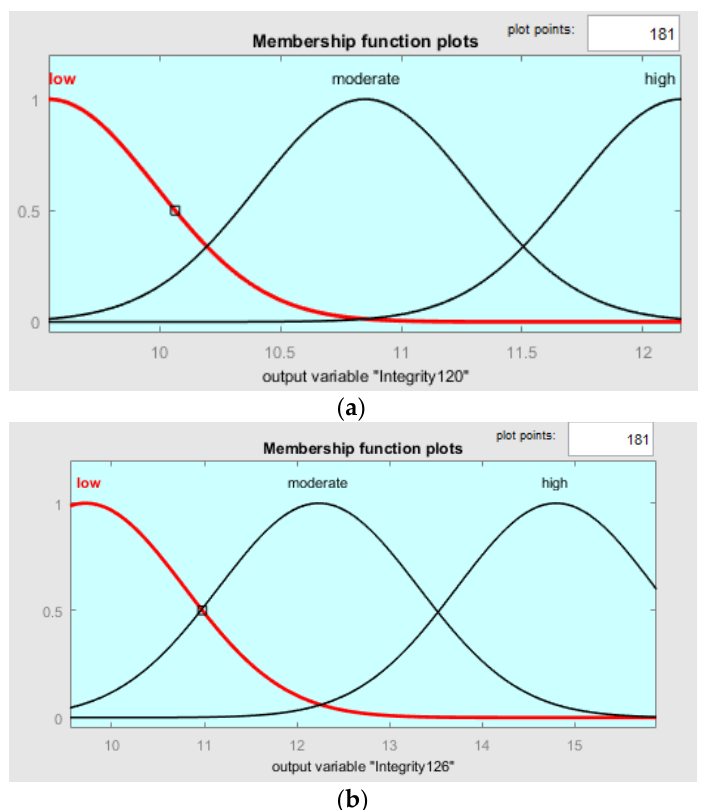
Figure 4. The shape of the membership function for output variables 𝑦 1 ( a ), 𝑦 2 ( b ) (Own study in MATLAB Fuzzy Logic Toolbox).